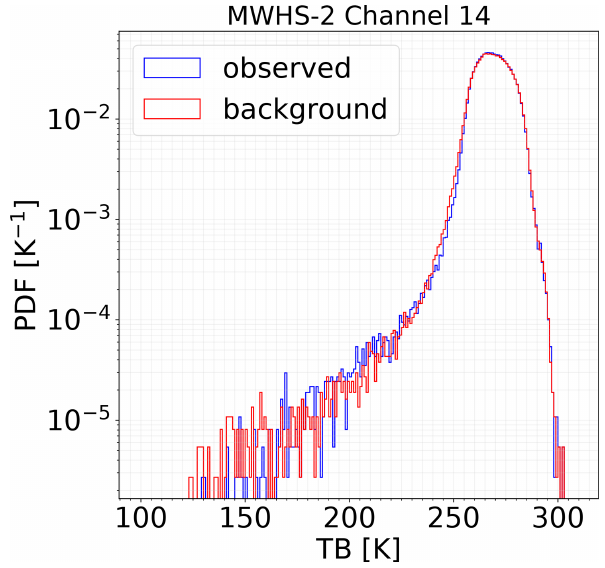
Figure 1. Probability distribution functions (PDFs) of simulated and observed brightness temperatures for MWHS-2 channel 14. The data cover a latitude range from 60 ◦ S to 60 ◦ N and satellite zenith angle of less than 7.5 ◦